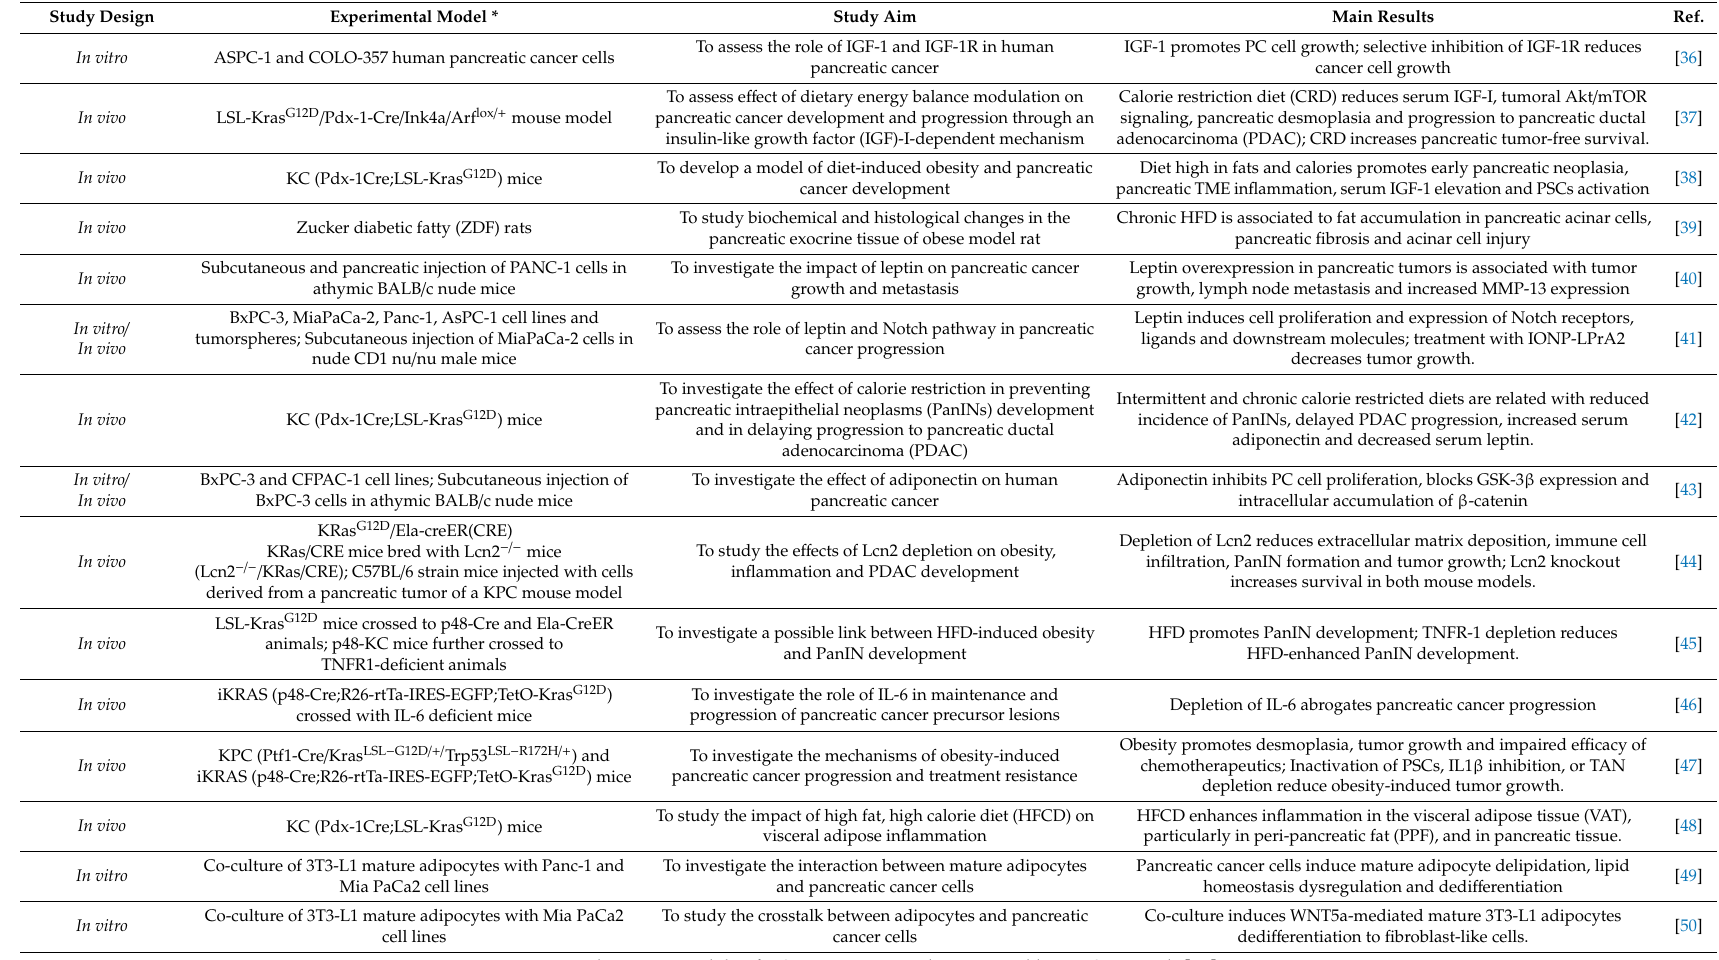
Table 1. Summary of main in vitro and in vivo studies investigating the link between dysfunctional adipose tissue and pancreatic